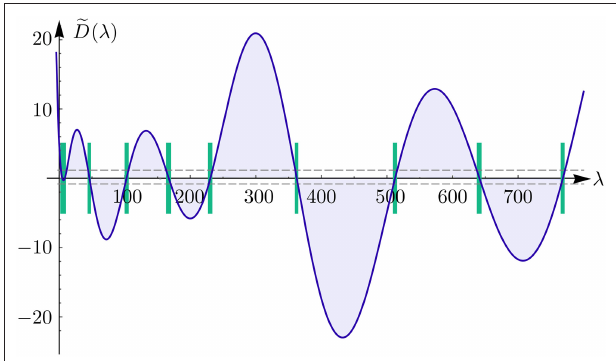
FIGURE 5 | Plot of the approximate function